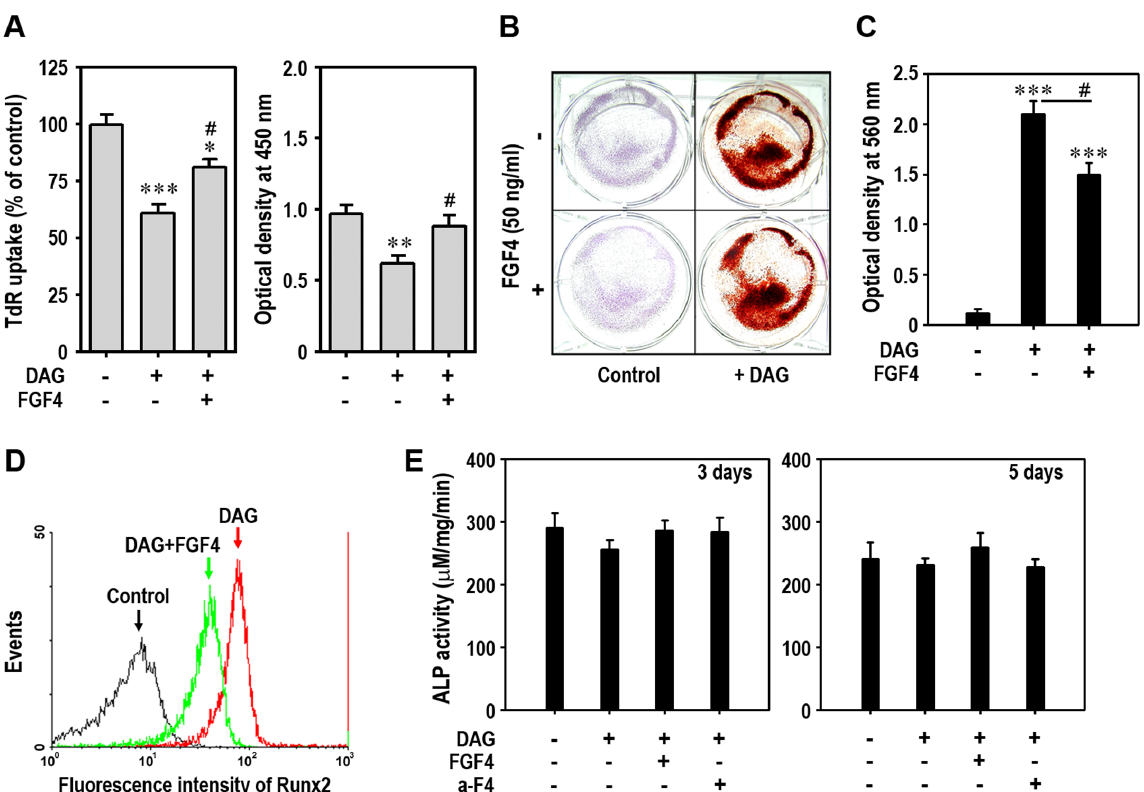
Figure 6. Exogenous FGF4 decreases osteogenic differentiation of mESCs. (A) mESCs were incubated in the presence of DAG and/or 50 ng/ ml FGF4. After 5 days of incubation, DNA synthesis (left panel) and cell proliferation (right panel) rates were determined. At the same time, cells were processed for Alizarin red staining (B) and absorbance of the dye (C) was also determined at 560 nm. (D) Runx2 protein in mESCs cultured with DAG and/or 50 ng/ml FGF4 for 5 days was analyzed by flow cytometry. (E) ALP activity in the cells was measured after 3 and 5 days of differentiation. *p , 0.05, **p , 0.01 and ***p , 0.001 vs. untreated control cells. # p , 0.05 vs. cells treated with DAG only.